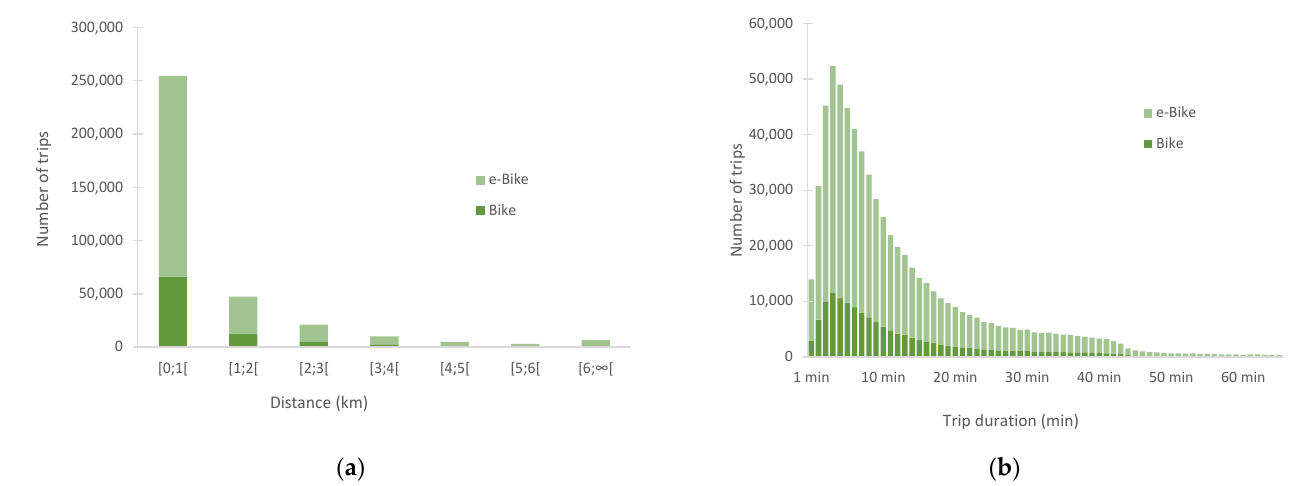
Figure 8. Trip characteristics ( a ) Number of trips per distance in 2018; ( b ) Number of trips per duration in 2018.